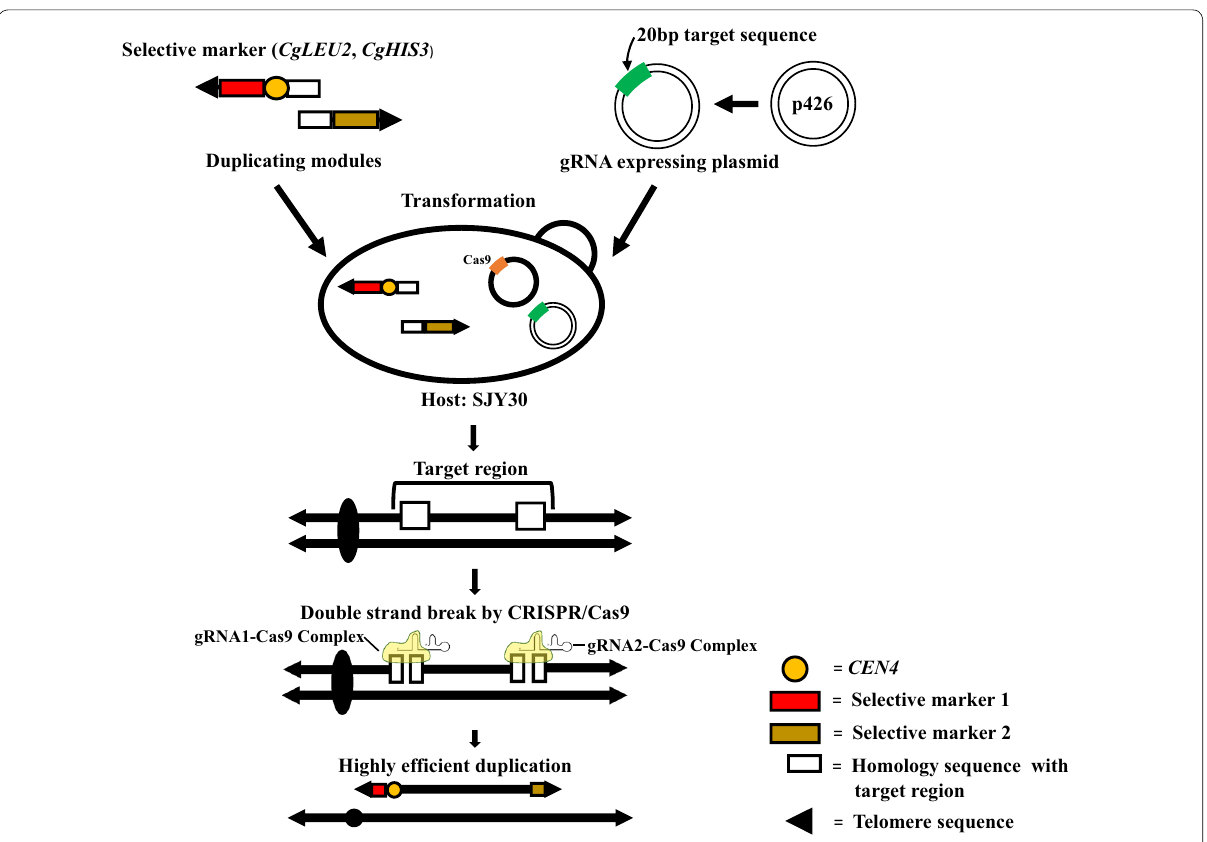
Fig. 1 Outline of the CRISPR-PCDup method. gRNA expressing plasmid and duplicating modules are introduced into the SJY30 strain, which harbors a Cas9-expressing plasmid. In transformed cells, CRISPR/Cas9 mediated double-strand breaks (DSBs) are induced near the target site. Chromosome duplication is then facilitated by PCDup. This new technology is named